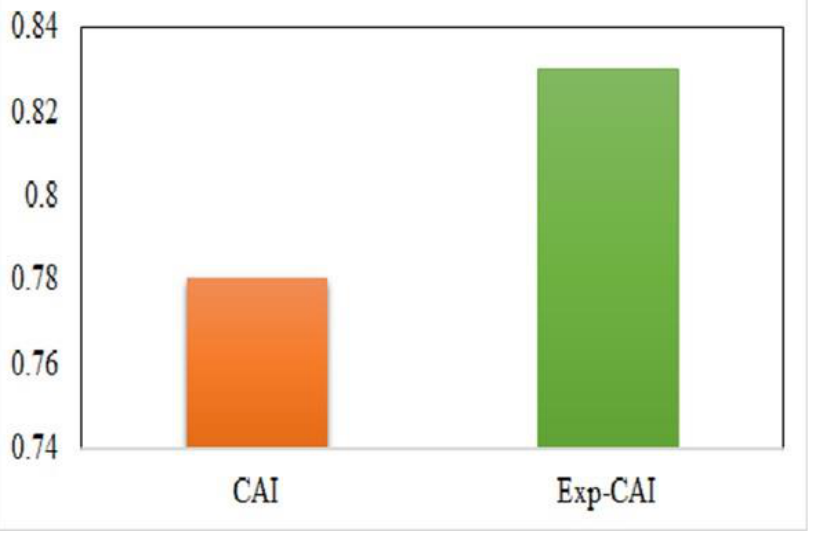
Figure 3. A codon usage adaptation index of RYMV to its host. In the plot, x -axis represents CAI and Exp-CAI. Y axis represents CAI value.